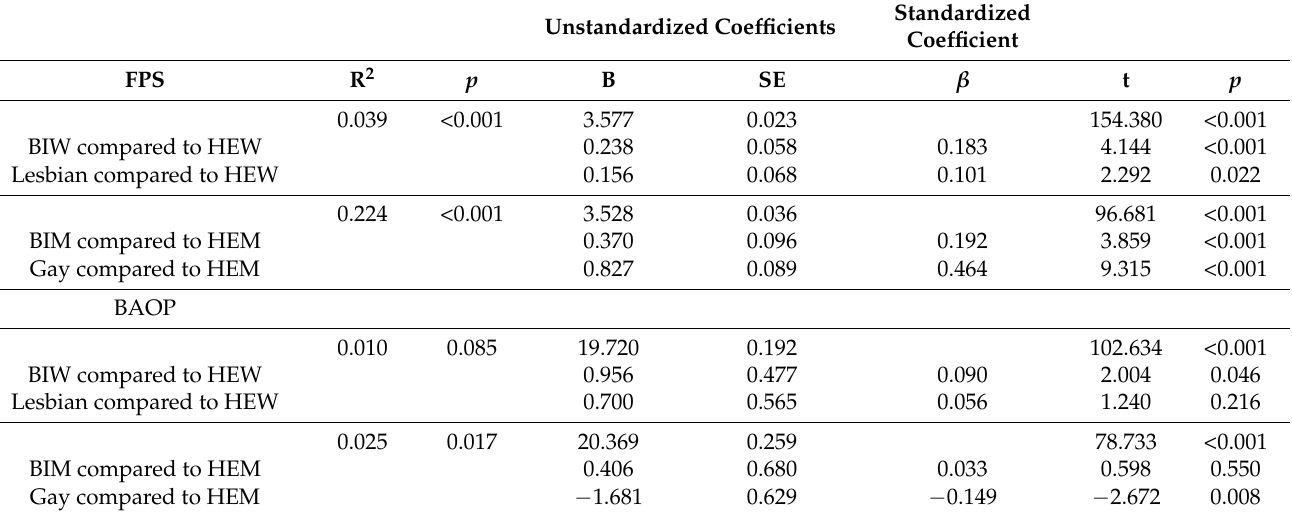
Table 4. Regression